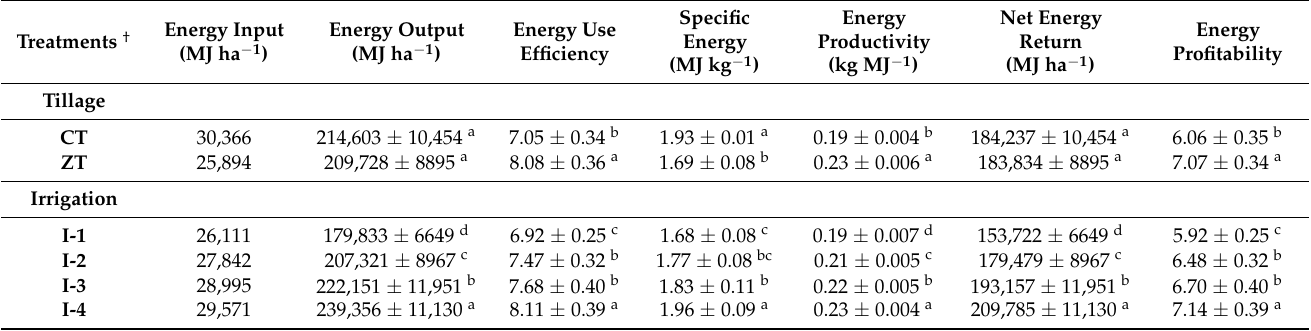
† Refer to Table 1 for treatment details. Mean ( ± values are standard deviations from means) followed by different superscript letters within each column indicate a significant difference among the treatments (at p < 0.05) according to the Duncan Multiple Range Test.